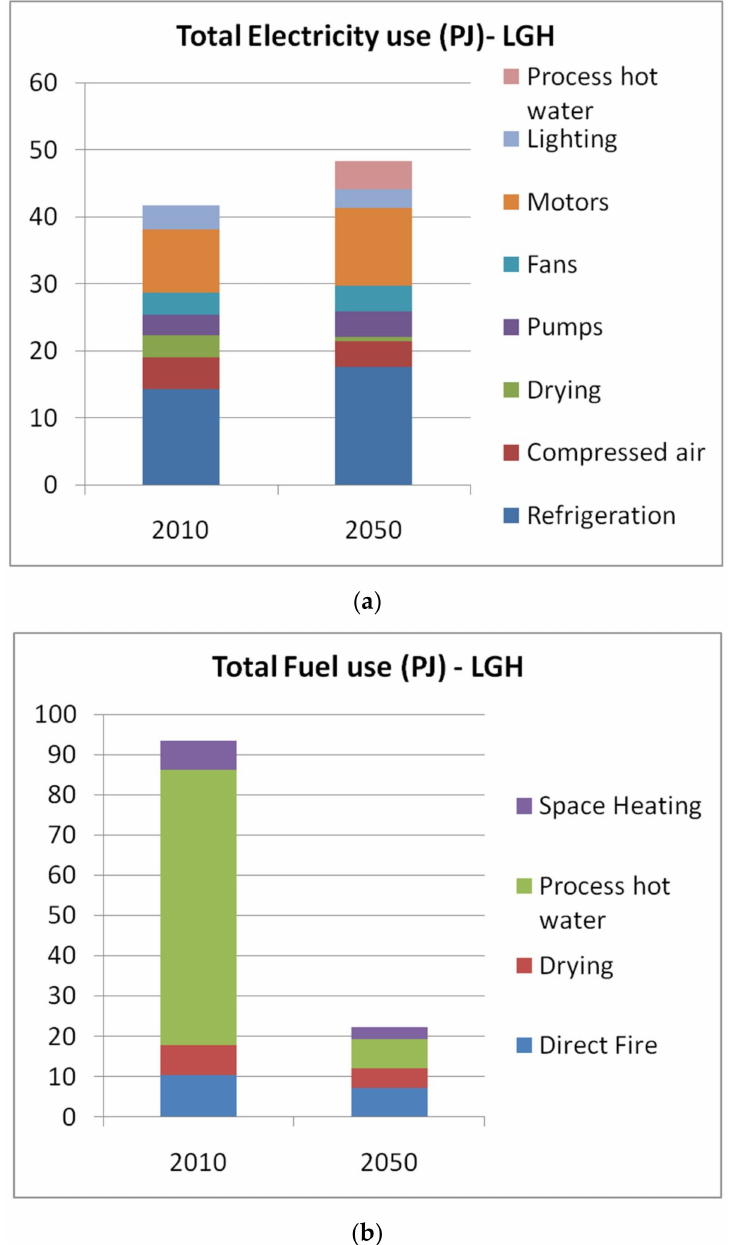
Figure 10. ( a ) Electricity end-uses in the LGH case; ( b ) fuel end-uses in the LGH case. (Note that legends and colours in Figure 10 are aligned in sequential order for ease of